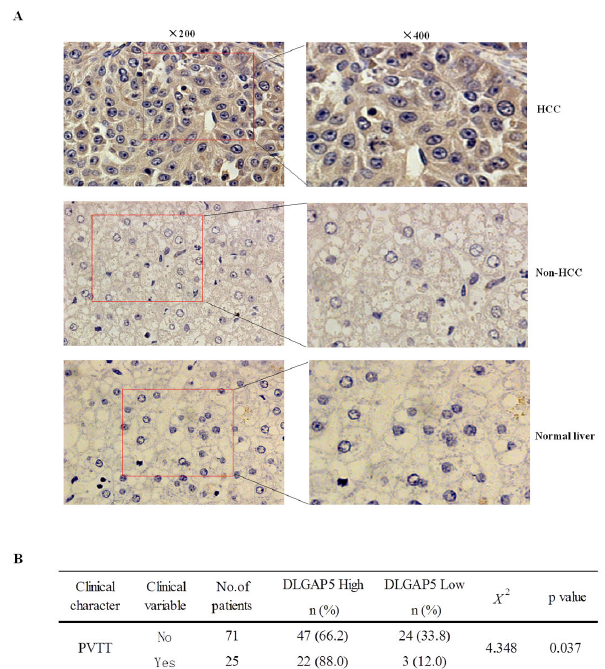
Figure 2. Protein expression pattern of DLGAP5 in HCC specimens. (A) Representative immunohistochemical DLGAP5 staining of a HCC specimen and its corresponding non-cancerous tissue from a tissue array containing 96 pairs of HCC specimens. The nuclei were counterstained with hematoxylin. Original magnification: The left (×200) and right side (×400) (normal, non-HCC and HCC). (B) Statistical analysis was performed using the chi-square test to compare the relative levels of DLGAP5 between HCC with PVTT and HCC without PVTT ( P =0.037).